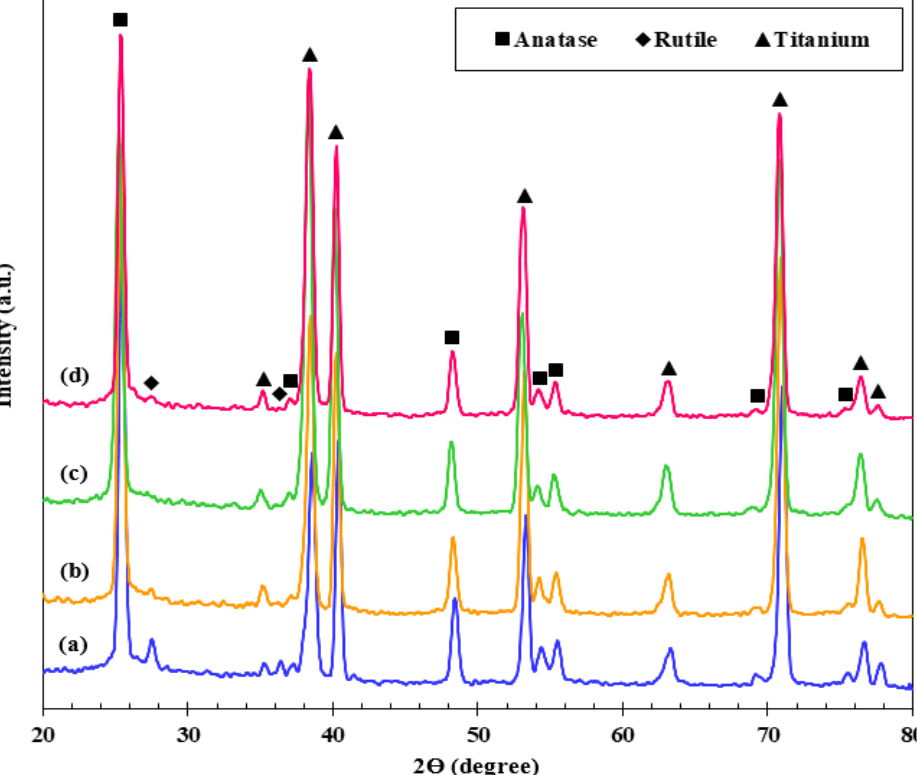
Figure 3. XRD patterns of the PEO coatings ( a ) without and with ( b ) 1 g/L, ( c ) 3 g/L, and ( d ) 5 g/L of anatase TiO 2 nanoparticles. Table 4. The anatase and rutile phases’ mass fraction of the PEO coatings without and with different concentrations of anatase TiO 2 nanoparticles.